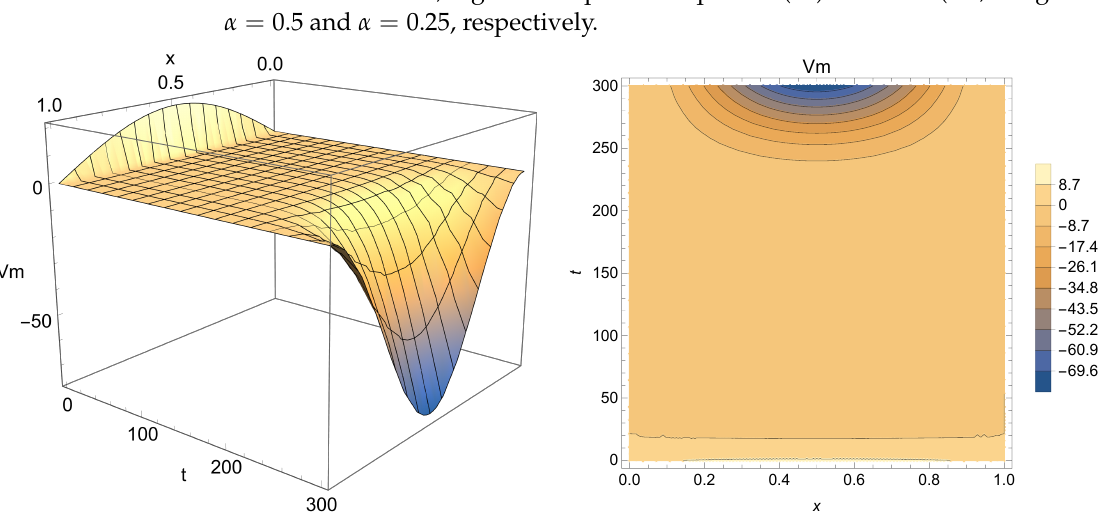
Figure 5. One-dimensional nonhomogeneous solution describing repolarization after the potential plateau: Equation (18) with α =